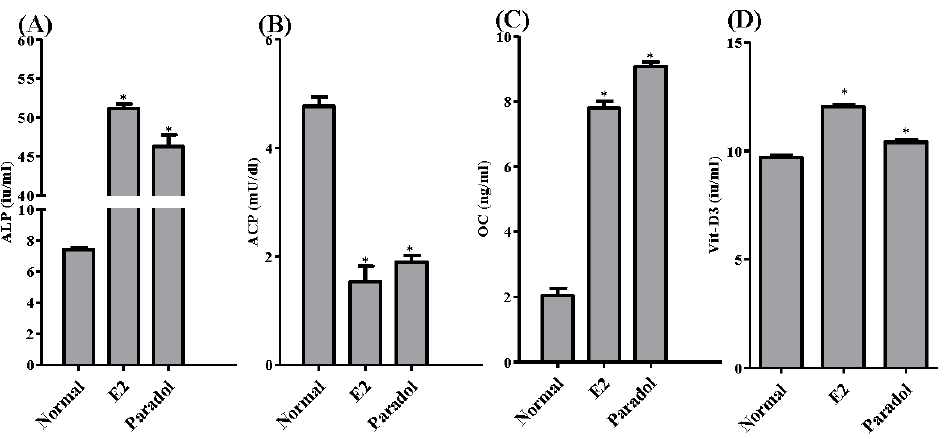
Figure 6. Biochemical assessment for antiosteoporotic effect of paradol in vitro. SAOS-2 cells were treated with paradol (1 uM) and E 2 (0.1 uM) for 48 h and compared to control untreated cells. Biochemical assessment of osteoporosis was evaluated by measuring alkaline phosphatase ( A ); acid phosphatase ( B ); osteocalcin ( C ); and vitamin-D3 ( D ). Data are presented as mean ± SD; n = 3. * Significantly different from control untreated cells; p < 0.05.